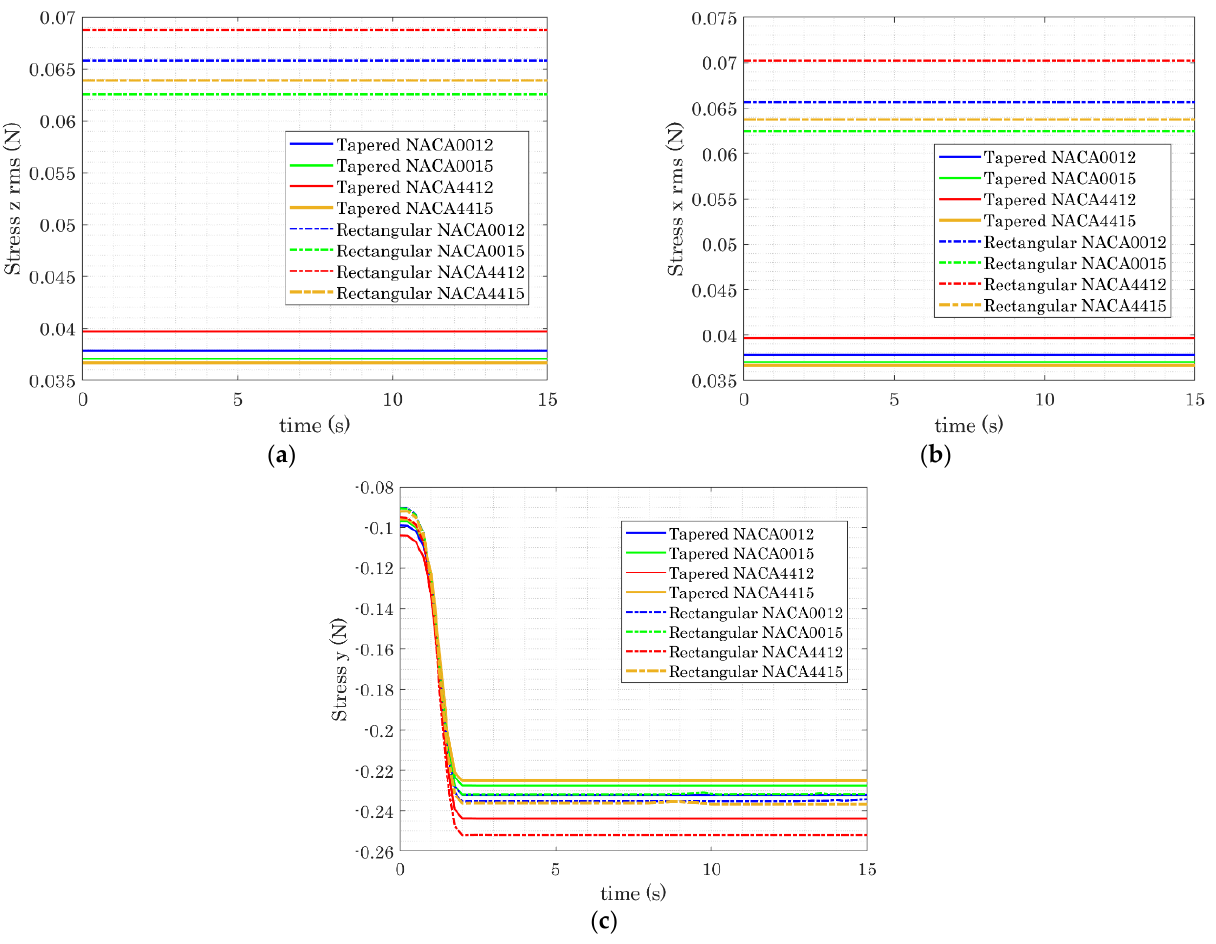
Figure 11. ( a ) x-stress rms, ( b ) z-stress rms, and ( c ) y-stress undergone by a single SSWT blade.